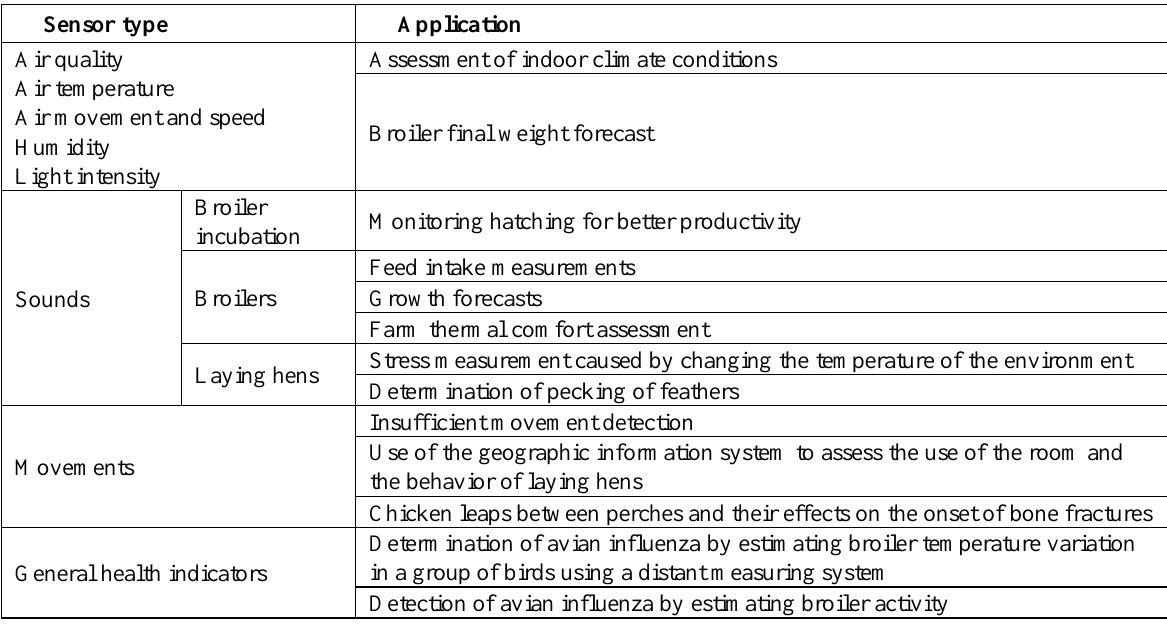
Table 1. Key sensor technologies and potential applications to improve poultry welfare [8],